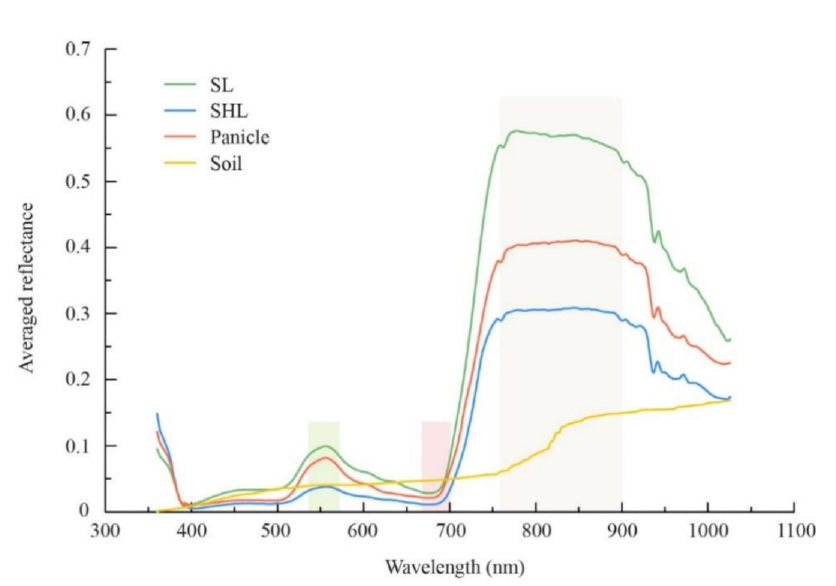
Figure 3. The average reflectance of sunlit leaf (SL), shaded leaf (SHL), panicle, and